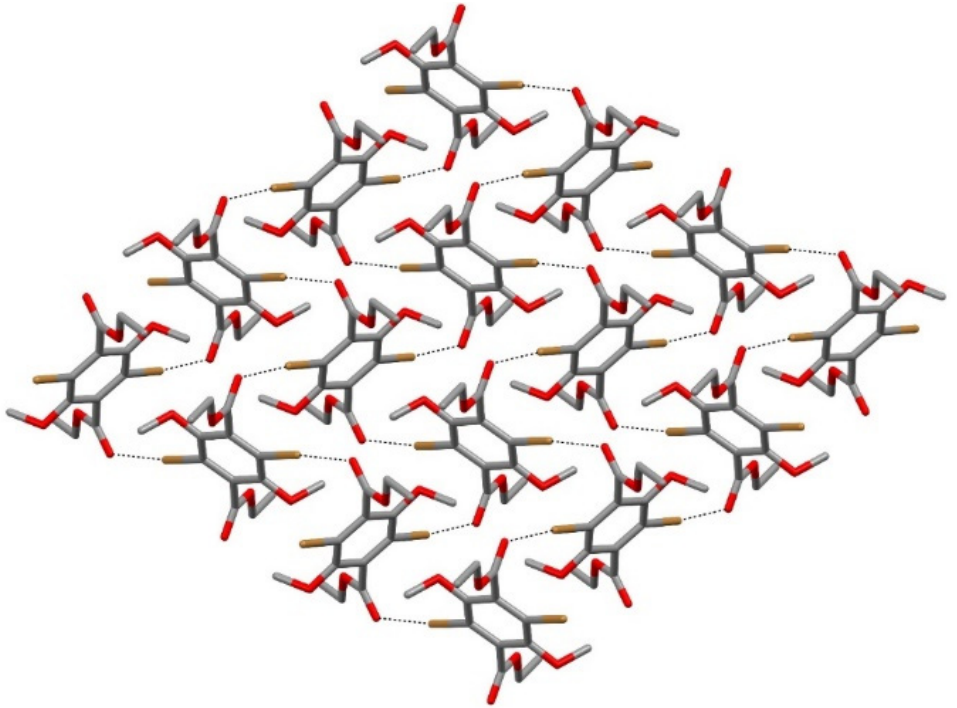
Figure 3. A simplified view of the halogen-bonded molecular sheet forming in the crystal of bromine compound 4a (hydrogens were omitted for clarity; dashed lines indicate the C Ar -Br · · · O carbonyl XB interactions). The same supramolecular arrangement occurs in the isostructural crystal of iodine compound 4b .